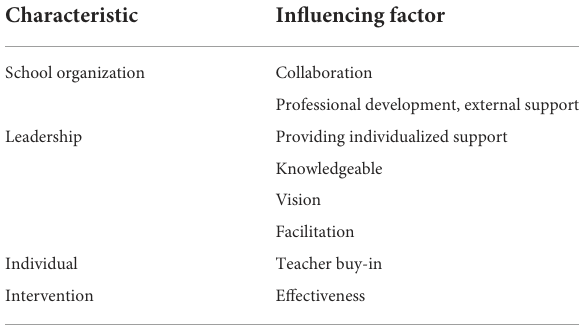
TABLE 4 Influencing factors after best evidence